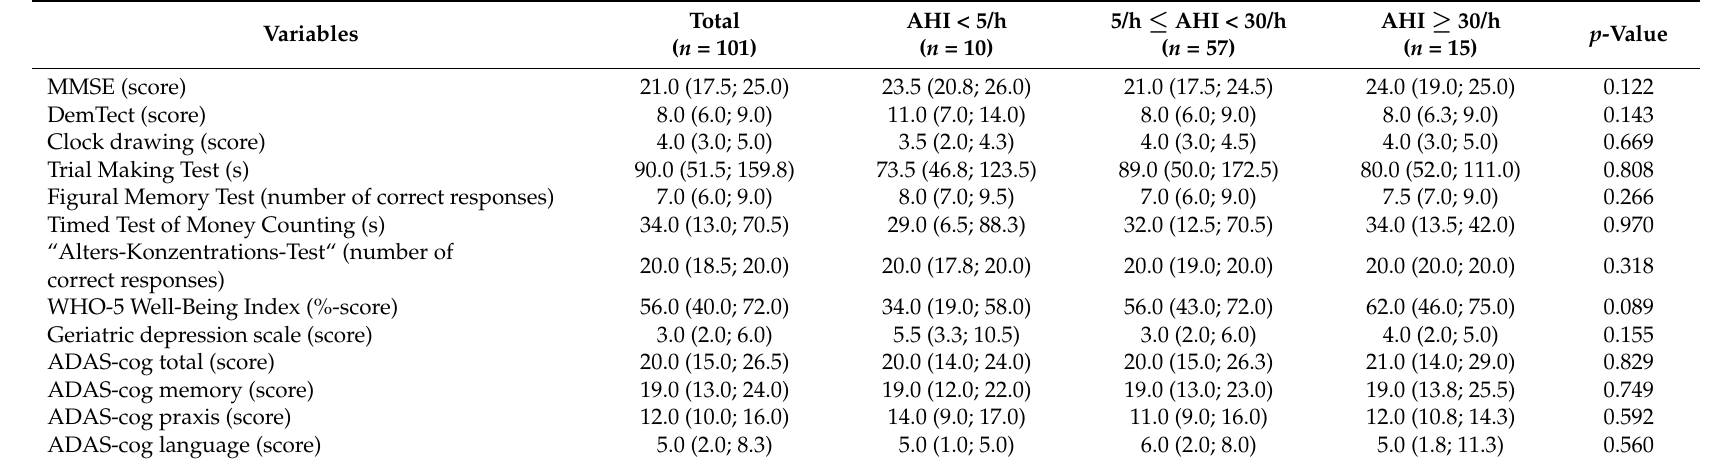
Table A3. Cognitive and emotional function also split by alternative AHI category.